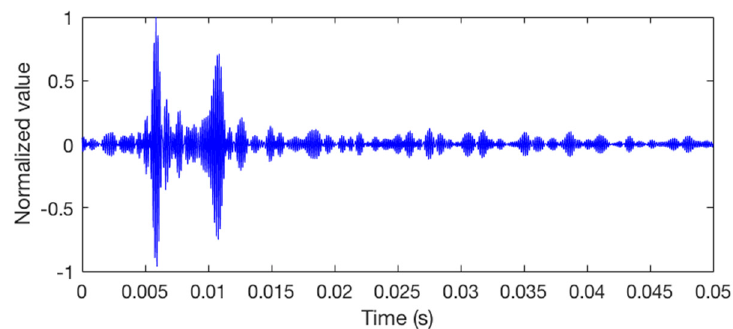
Figure 10. The CIR corresponding to a certain frame data.